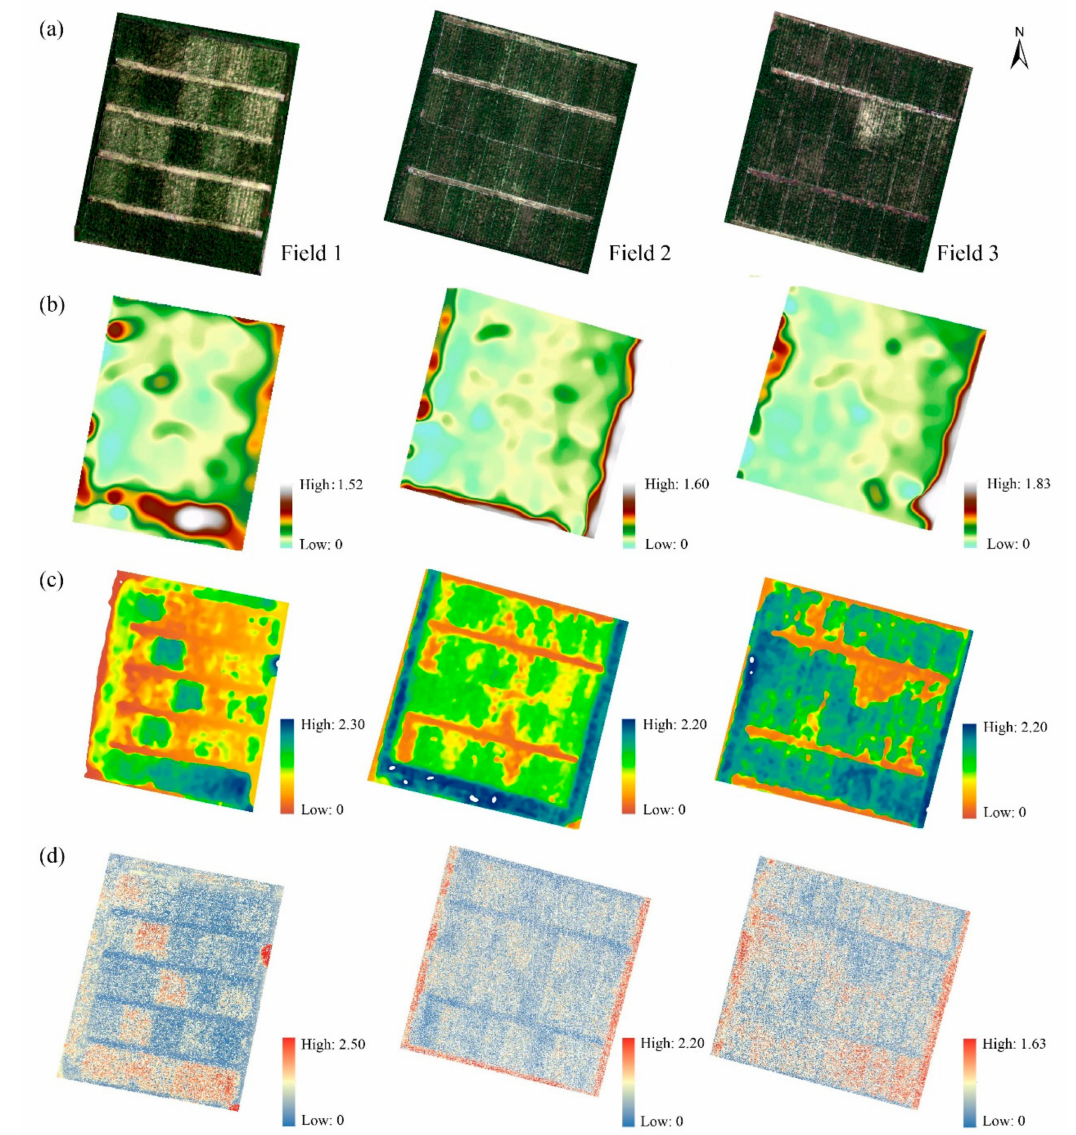
Figure 5. ( a ) The RGB maps of three experimental fields; the crop height raster data based on ( b ) the multiSPEC-4C, ( c ) the Micasense RedEdge-M, and ( d ) the LiDAR point